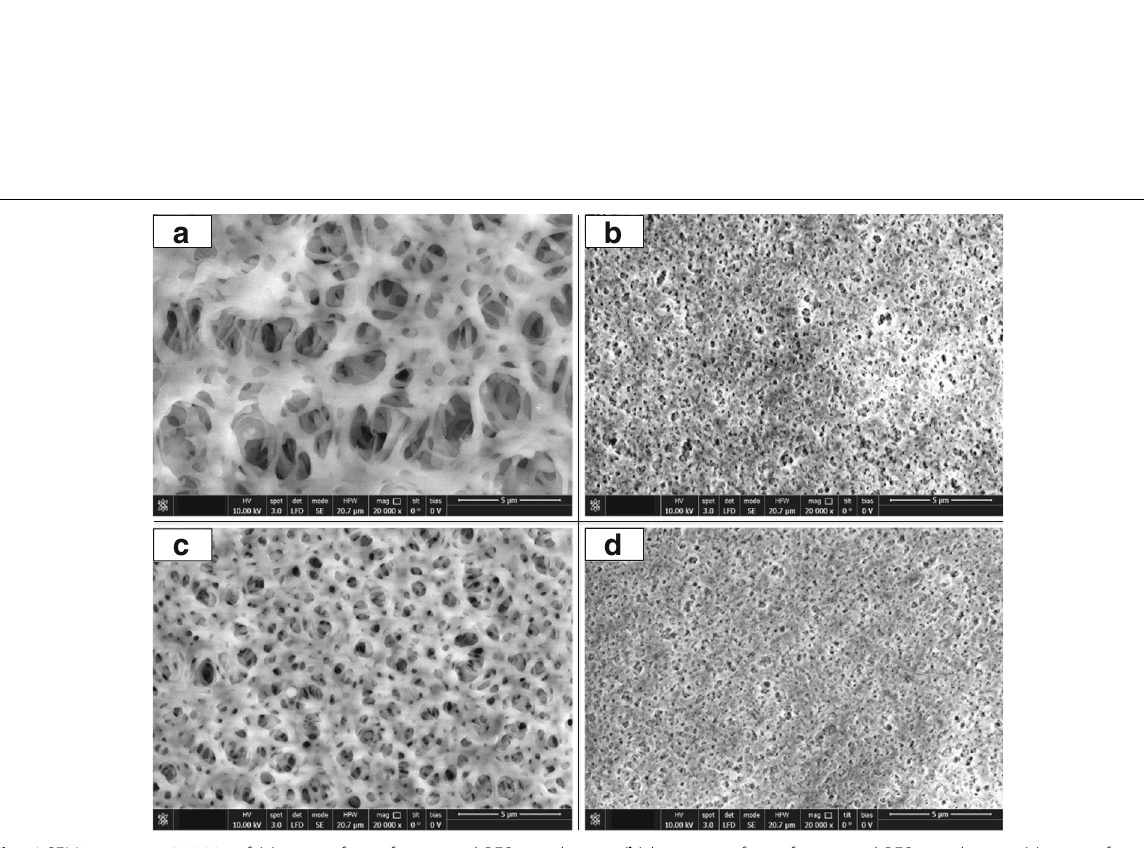
Fig. 6 SEM images at 20,000x of ( a ) top surface of untreated PES membranes, ( b ) bottom surface of untreated PES membranes, ( c ) top surface of CF4 plasma treated PES membranes, ( d ) bottom surface of CF4 plasma treated PES